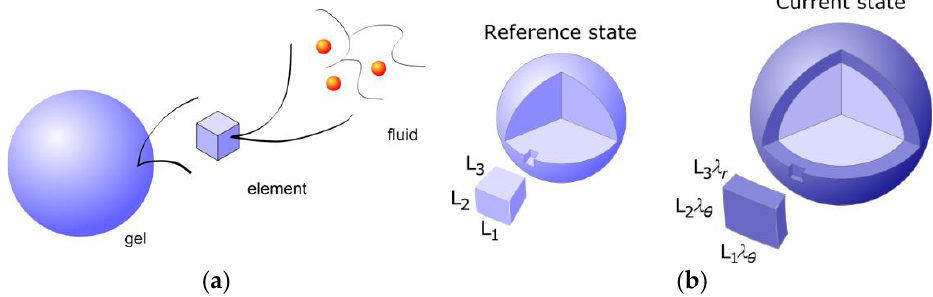
Figure 5. ( a ) A spherical gel described as a collection of small volume elements containing the molecular fluid; ( b ) a gel in the reference state (left) and in the current biphasic state (right). In the latter state, the deformation of the volume elements in the shell in the radial direction ( λ r ) is different from that in the circumferential directions ( λ θ ). Figure taken from ref. [74]. Reprinted with the permission of AIP Publishing.